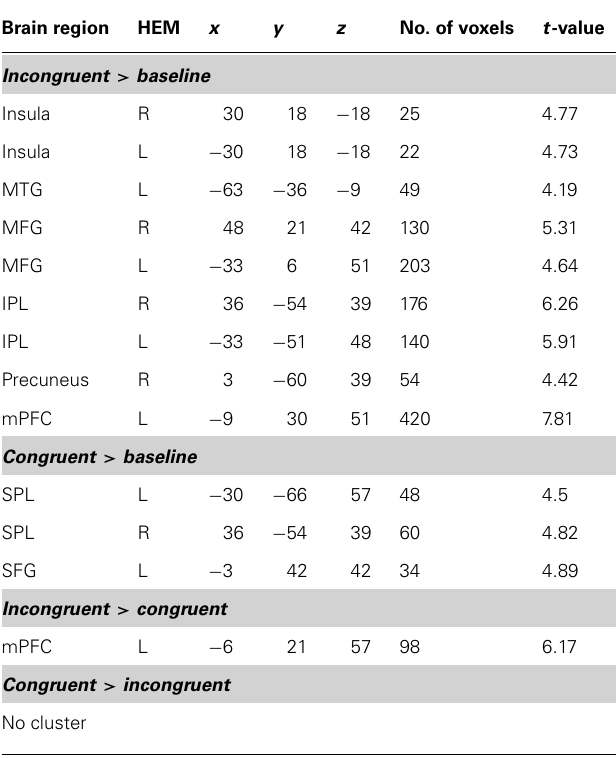
Table 2 | Significant activation clusters for social